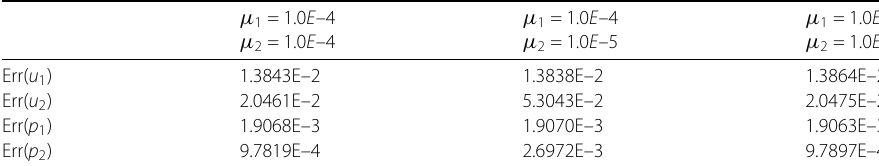
Table 3 Errors for the different small viscosities based on stabilized P 1 – P 1 pair